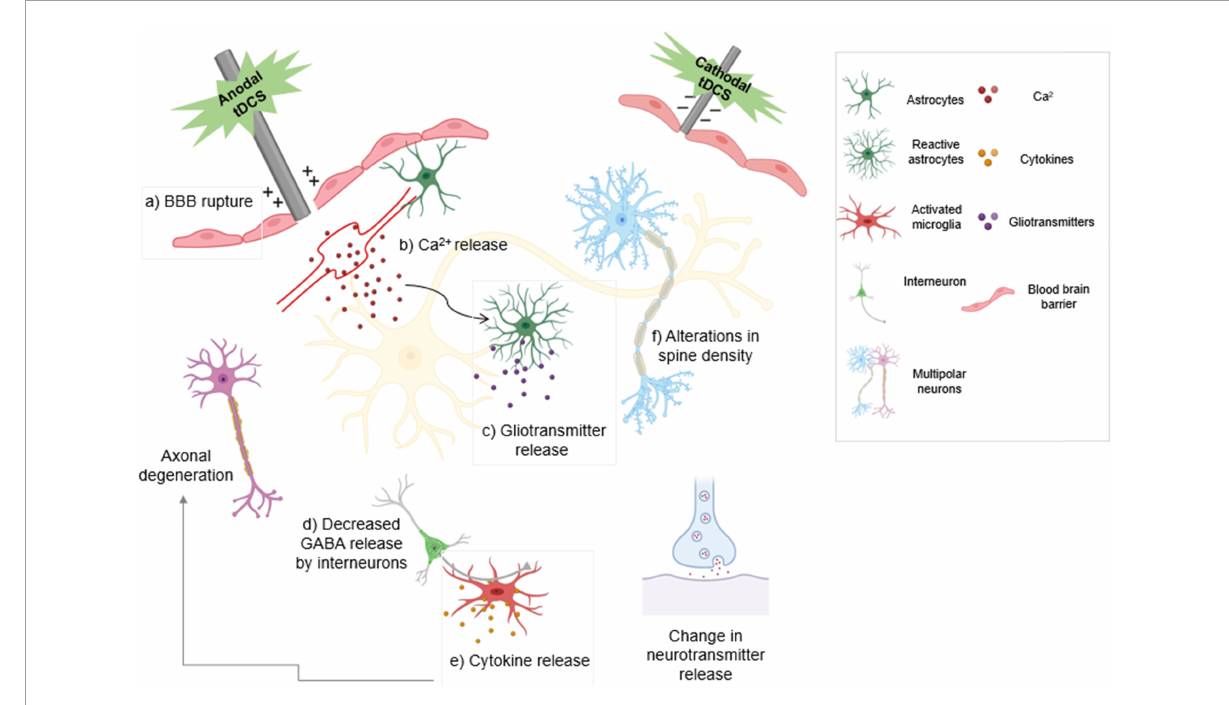
FIGURE2 The type of stimulation determines the modulatory effect of transcranial direct current stimulation (tDCS). Anodal stimulation depolarizes the neuronal membrane and enhances neuronal excitability. Cathodal stimulation hyperpolarizes the neuronal membrane and reduces neuronal excitability. Anodal tDCS exacerbates bleeding and damage to the blood-brain barrier following ischemic injury. (a) tDCS activates noradrenergic fibers that release noradrenaline, increasing (b) astrocytic Ca 2 + levels and release of gliotransmitters (c). Decreased GABA release by both anodal and cathodal tDCS results in decreased inhibition (d). Activated microglia release cytokines that cause inflammation and result in axonal degeneration (e). Anodal tDCS is involved in increasing dendritic spine density (f). tDCS also leads to change in neuronal neurotransmitter release. Boxed panels indicate effects on non-neuronal cell